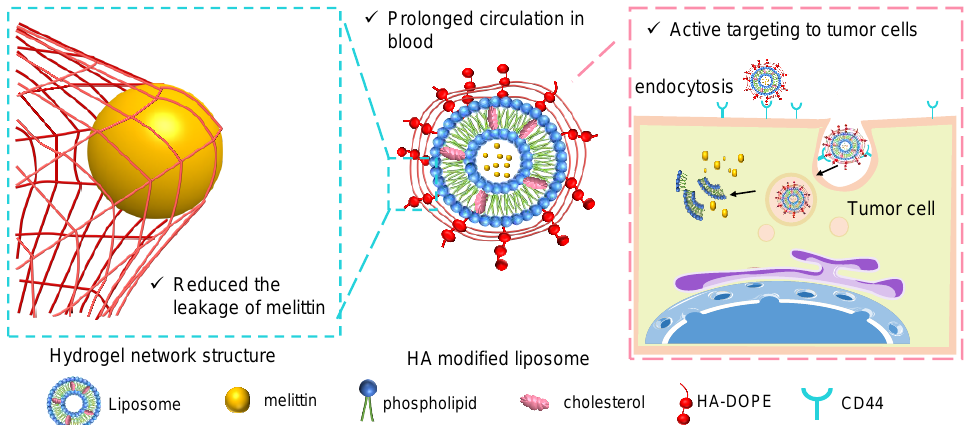
Figure 1. A schematic diagram of Mel-HA-Lip inhibiting the leakage of encapsulated melittin and enhancing drug delivery to tumor cells.